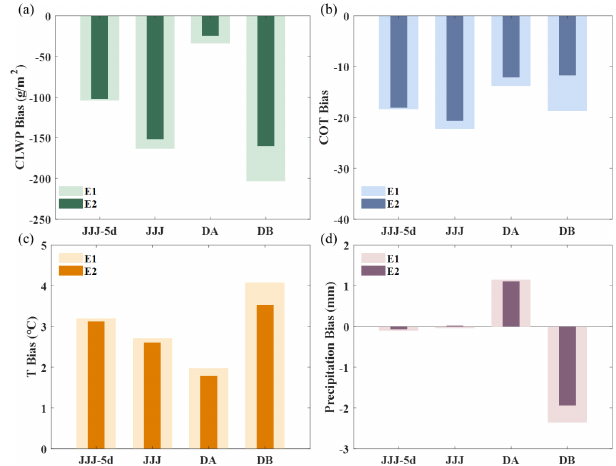
Figure 10. Comparisons of the mean bias of simulations from the E1 and E2 experiment for JJJ-5d and a day (7 January 2017) in Jing– Jin–Ji (JJJ), DA, and DB. (a) CLWP. (b) COT. (c) 2m temperature in the daytime. (d) 24h cumulative